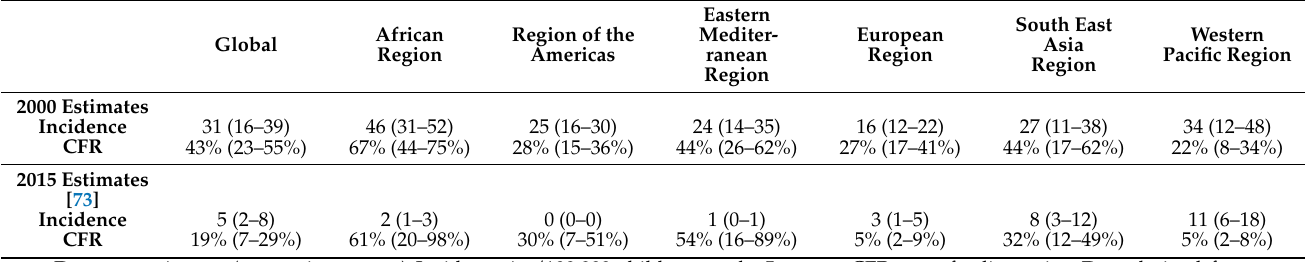
Table 2. Estimated incidence and case fatality ratio of Hib meningitis (with uncertainty estimates) by WHO region in 2000 and